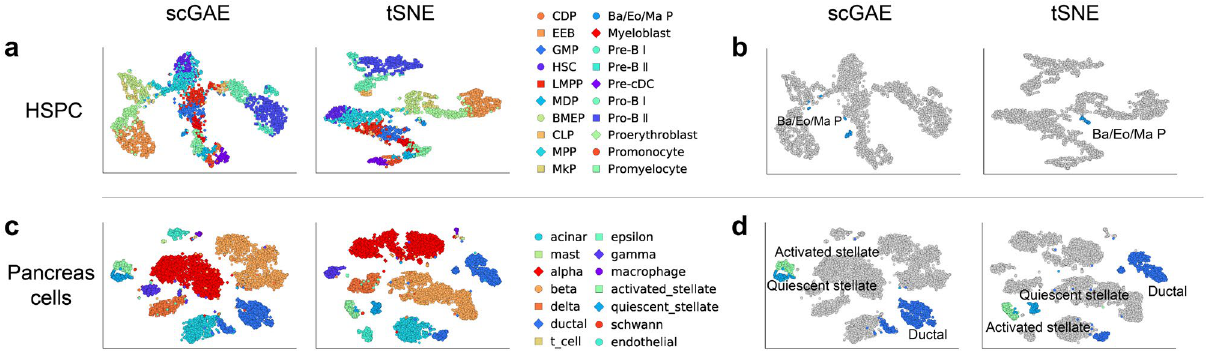
Figure 4. Analyses of two real datasets. ( a ) Visualization of HSPC cells by scGAE and tSNE ( b ) scGAE identified the multiple subpopulations in previous reported Ba/Eo/MaP. ( c ) Visualization of pancreases